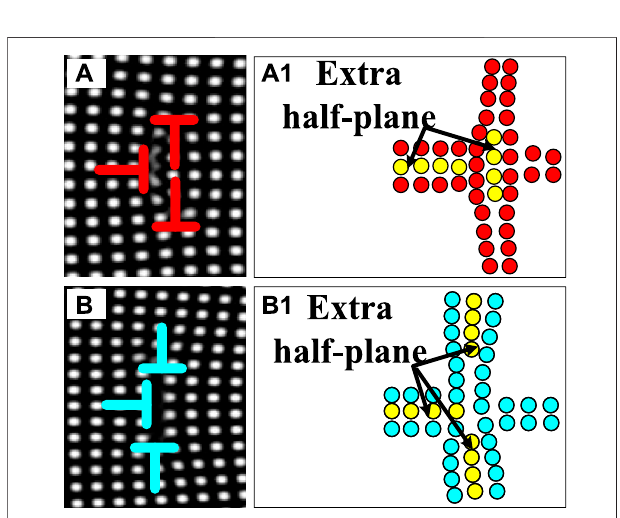
FIGURE8|(A) , (A1) Dislocationdecompositionunder x -directiontensile strain and its atomic structure diagram. (B) , (B1) Dislocation decomposition under y -direction tensile strain and its atomic structure concurrently between all dislocation pairs such as A7 and B5 (blue dotted circle in Figure 4B ), and fi nally, the lattice distortion disappears completely into a single crystal.